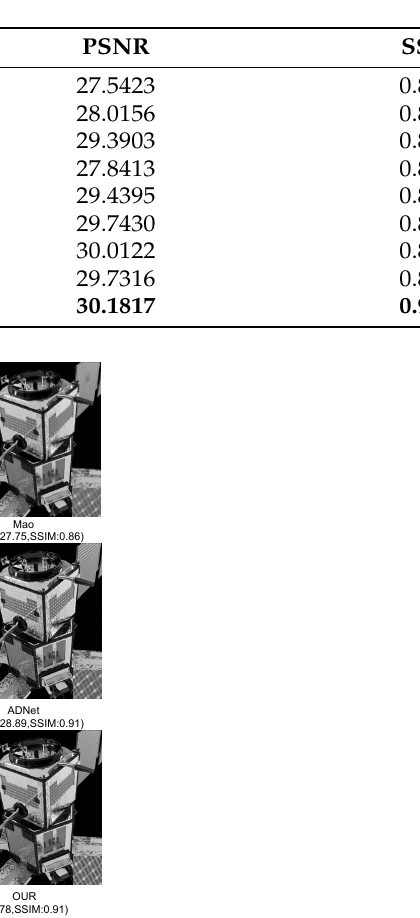
Table 3. Average PSNR and SSIM of different state-of-the-art methods on mild degradation (The best results are shown in bold fonts).